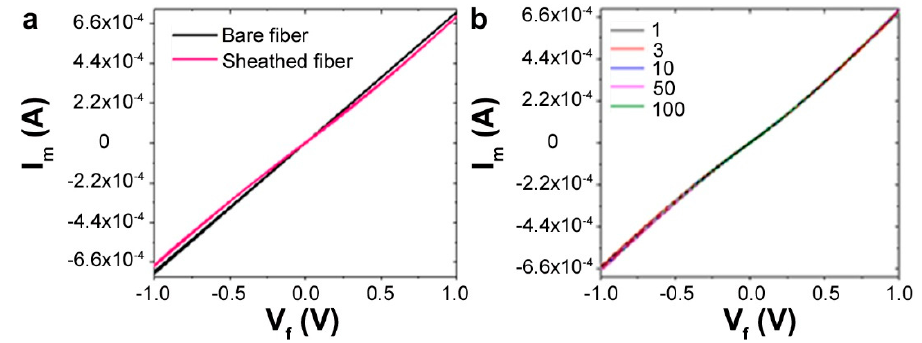
Figure 6. ( a ) The conductivity comparison (I–V) between the bare and sheathed fibers. ( b ) Conductivity across multiple cycles of testing for the sheathed fibers reveals their stability.